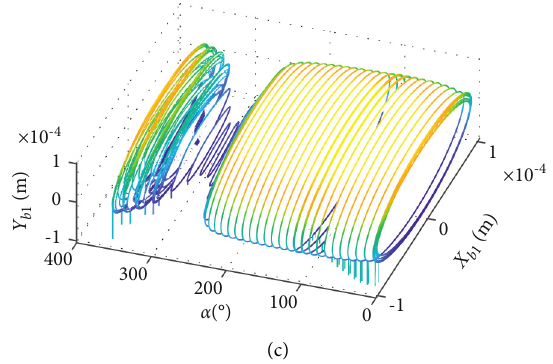
Figure 13: Waterfall diagram of axis trajectory varying with α : (a) 2000rpm; (b) 5000rpm; (c) 8000rpm.